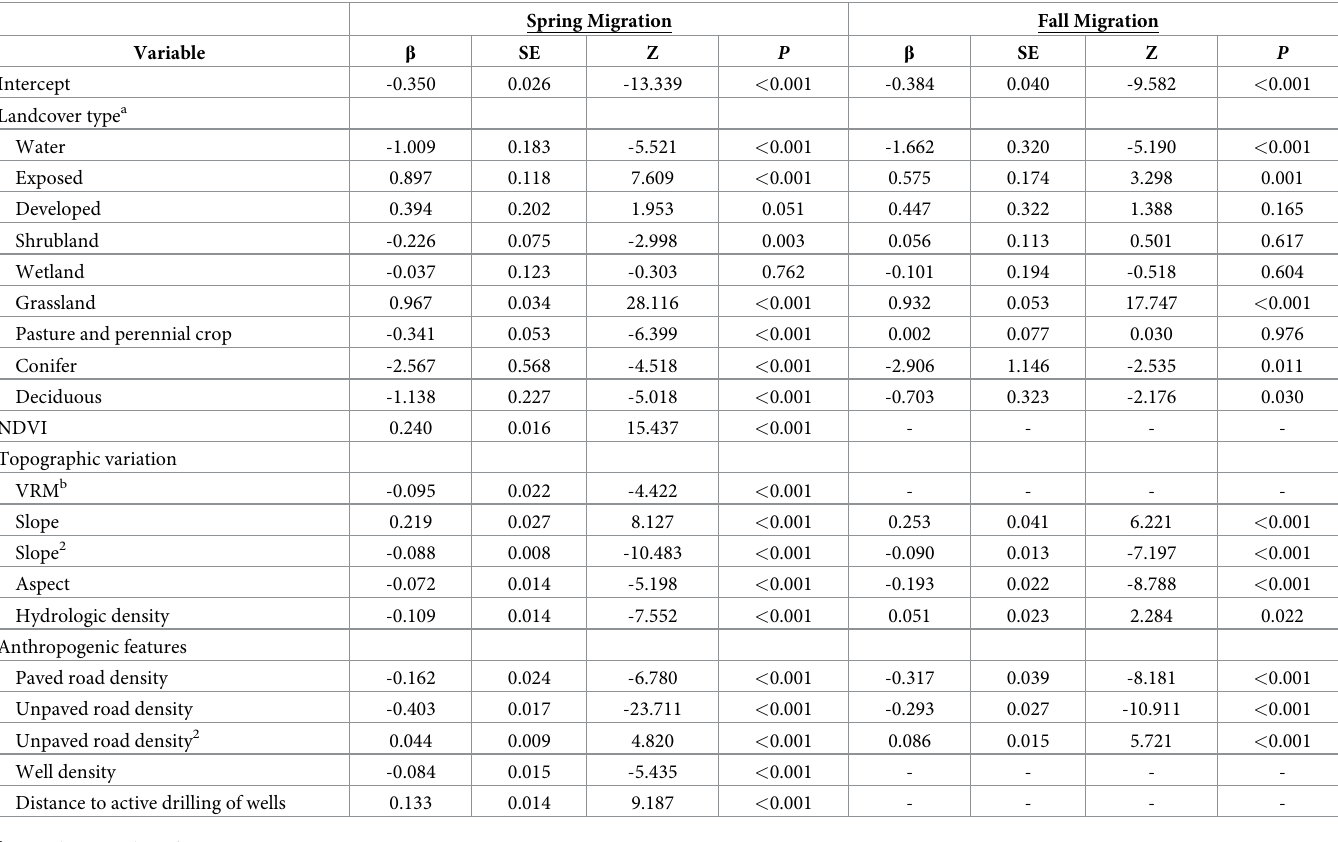
Table 1. Top second-order resource selection function model standardized coefficients for female pronghorn migratory neighborhood selection during spring and fall migration across the Northern Sagebrush Steppe, 2004–2010. Spring Migration Fall